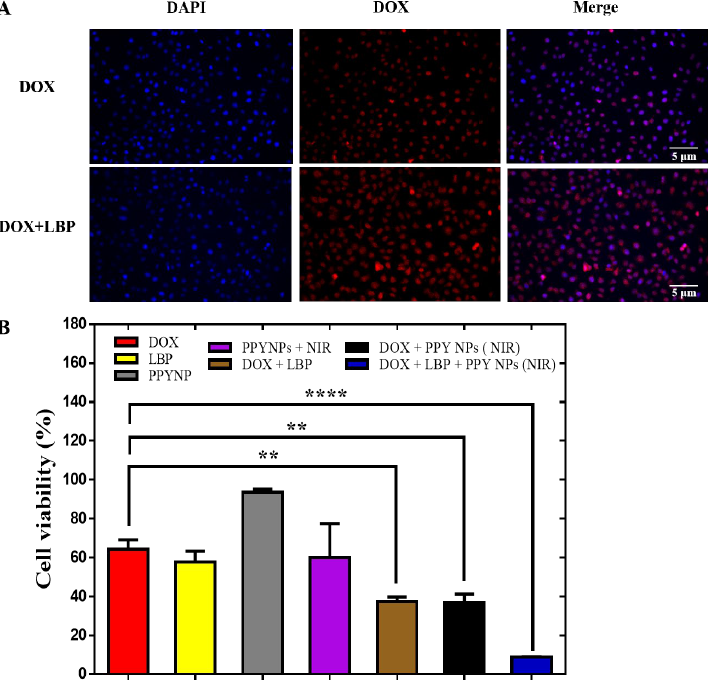
Figure 3. Fluorescence images of 4T1 cells after incubation with different drugs for 4h ( A ); in vitro cytotoxicity studies of DOX + LBP combined with PPY NPs (+NIR) against 4T1 cells at 72 h (n = 5) ( B ). ** p < 0.01, **** p < 0.0001. ( B ). ** p < 0.01, **** p <